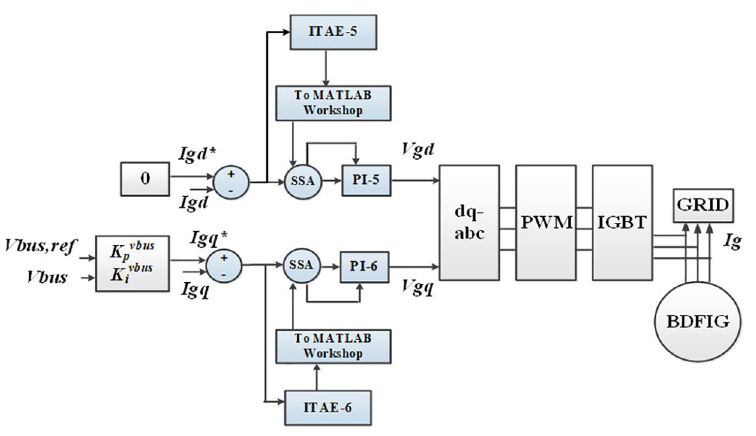
Fig 5. Grid side